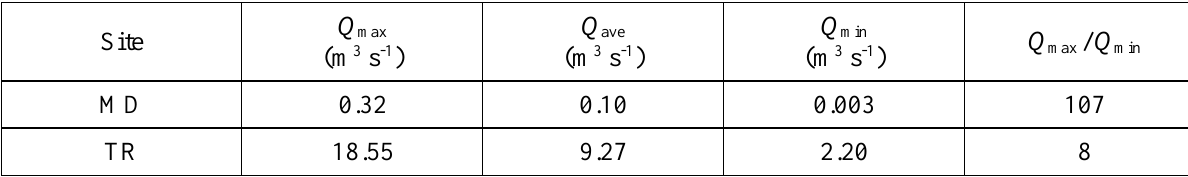
Table 1. Discharge characteristics of Meranti Ditch (MD) and Turip River (TR), calculated for the period 25 May 2012 to 08 February 2013 (259 days). (Q max / Q min ) is the coefficient of streamflow regime.